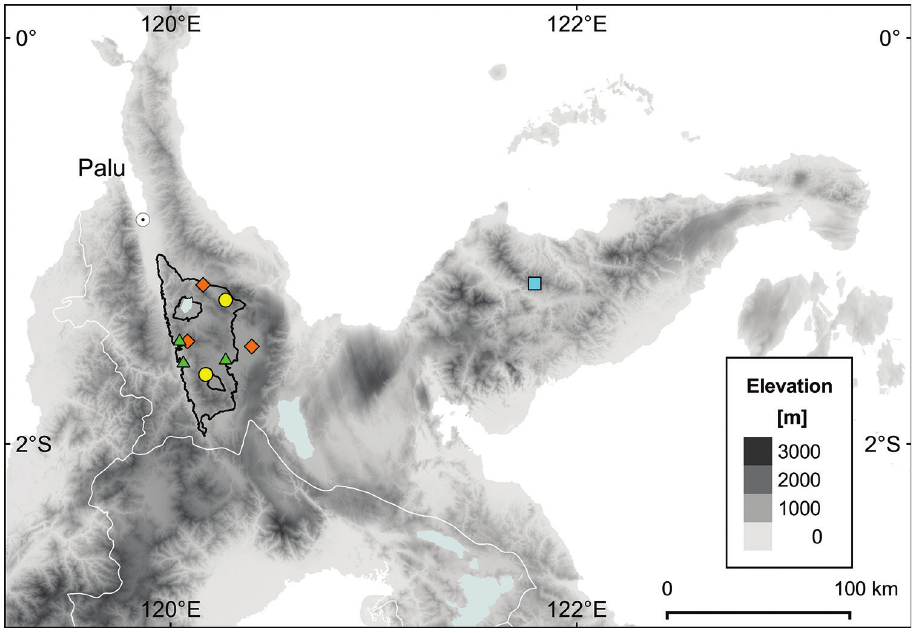
Figure 4. Distribution map of four species of Syzygium in Central Sulawesi: Syzygium contiguum (orange diamonds), S. devogelii (yellow dots), S. eymae (light blue square), and S. galanthum (green triangles). Lore Lindu National Park is indicated by a black line. Map created with QGIS (QGIS Development Team 2016) using the digital elevation model of Jarvis et al.